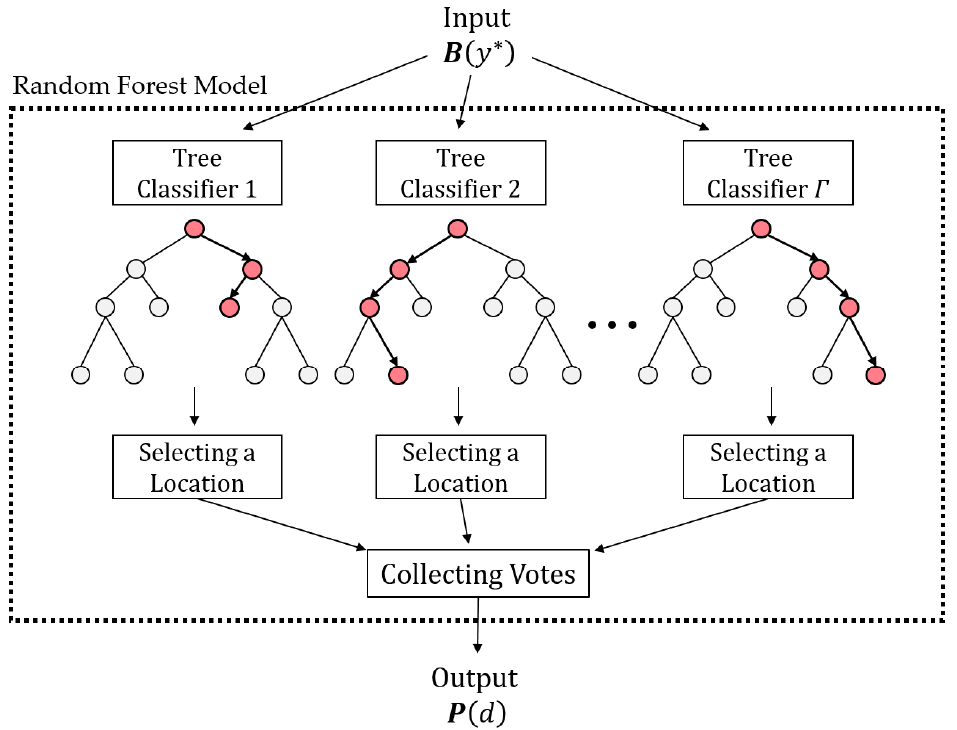
Figure 5. The overall structure of a random forest model for source identification.